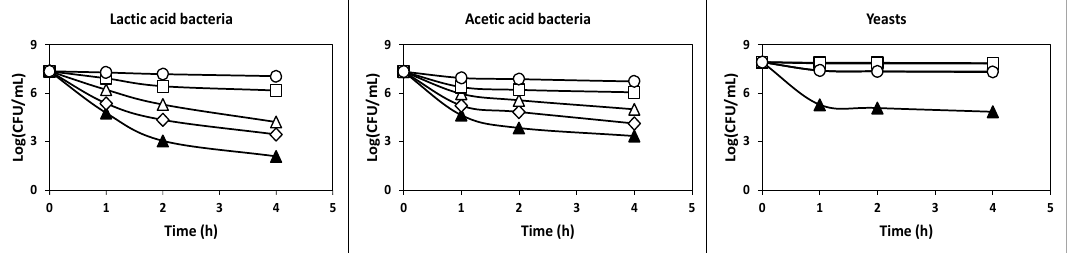
Figure 6. Survival of LAB, AAB and yeasts incubated in phosphate-buffered saline at pH values 1.0 ( black triangles ), 2.0 ( diamonds ), 3.0 ( white triangles ), 4.0 ( squares ) and 5.0 ( circles ). The experimental data represent the means of three experiments and two analytical replicates.